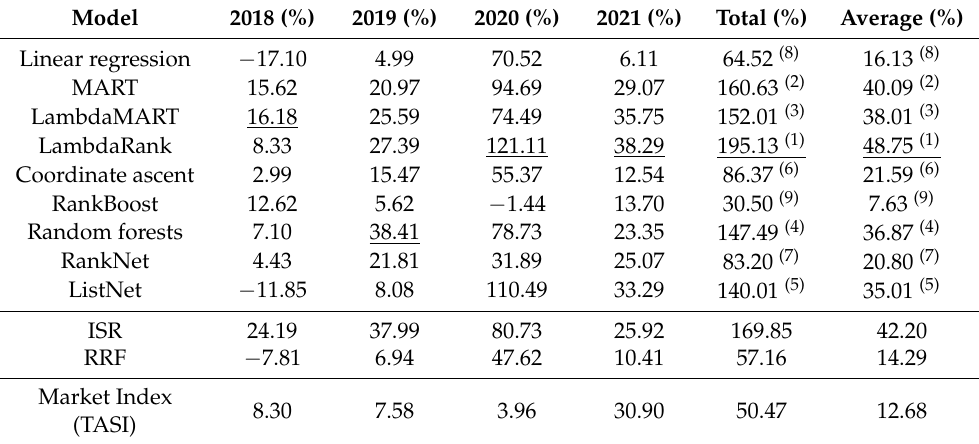
Table 8. The returns produced by each model’s simulated portfolio (top 20 selected stocks) for the four years, 2018, 2019, 2020, and 2021. Underlined values represent the models with the highest earnings. Superscript numerals in parentheses represent the rank of a model among all models based on total and average returns.